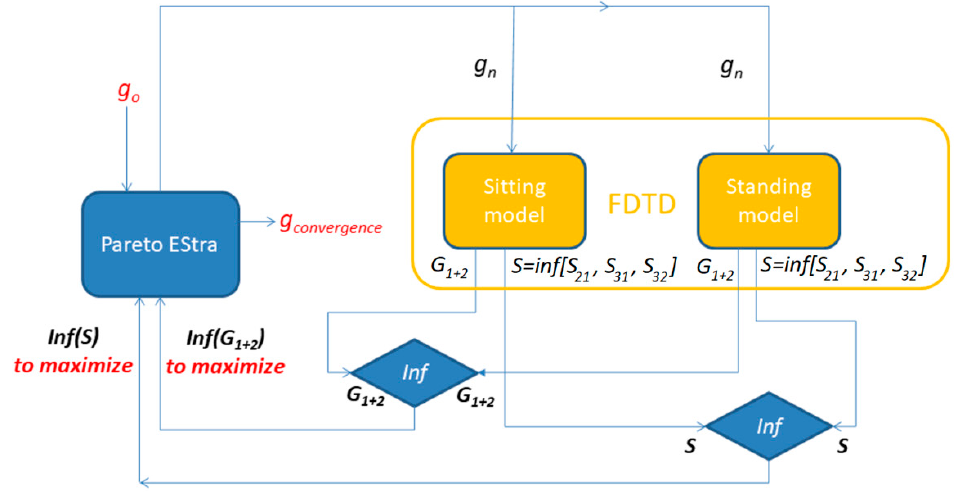
Figure 9. The flowchart of the computational scheme.